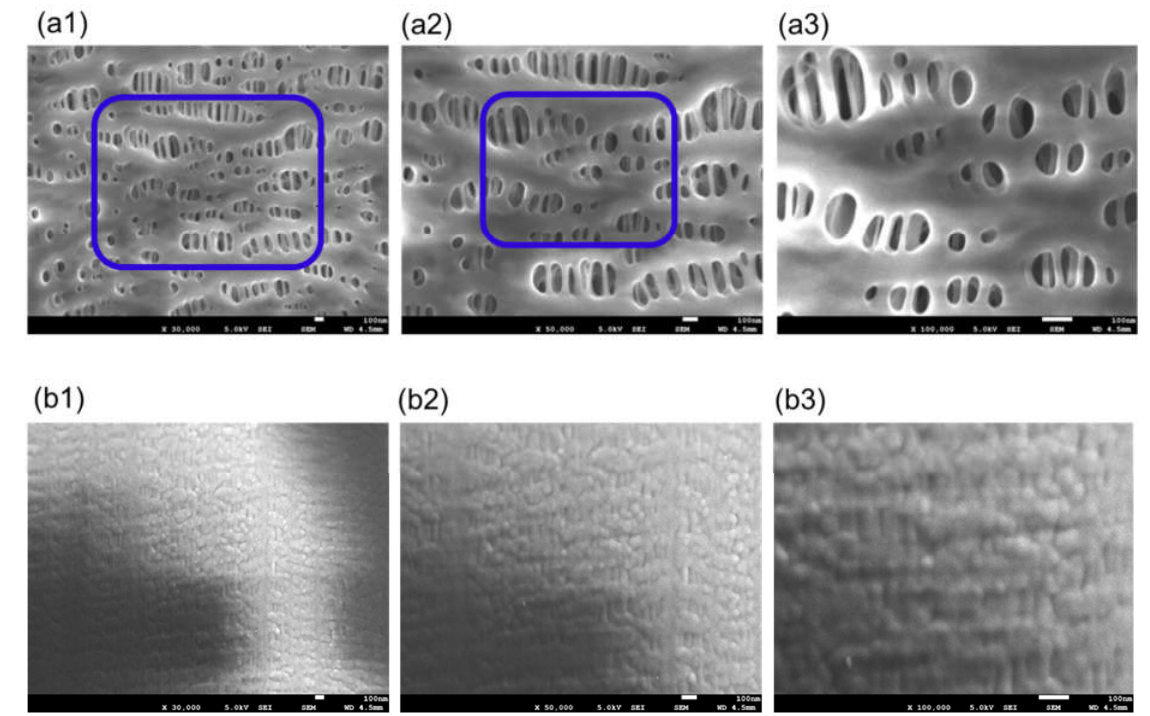
Figure 4. FE-SEM images of MERA NHP ® (dry), ( a ) the surface of inner lumen of the capillary membranes, ( b ) the outer surface of the capillary membranes: (1) × 30,000; (2) × 50,000; and (3) × 100,000, respectively. The image of (3) shows magnified images of the pores enclosed by the blue square in (2), and the image of (2) shows magnified images of the pores enclosed by the blue square in (1).